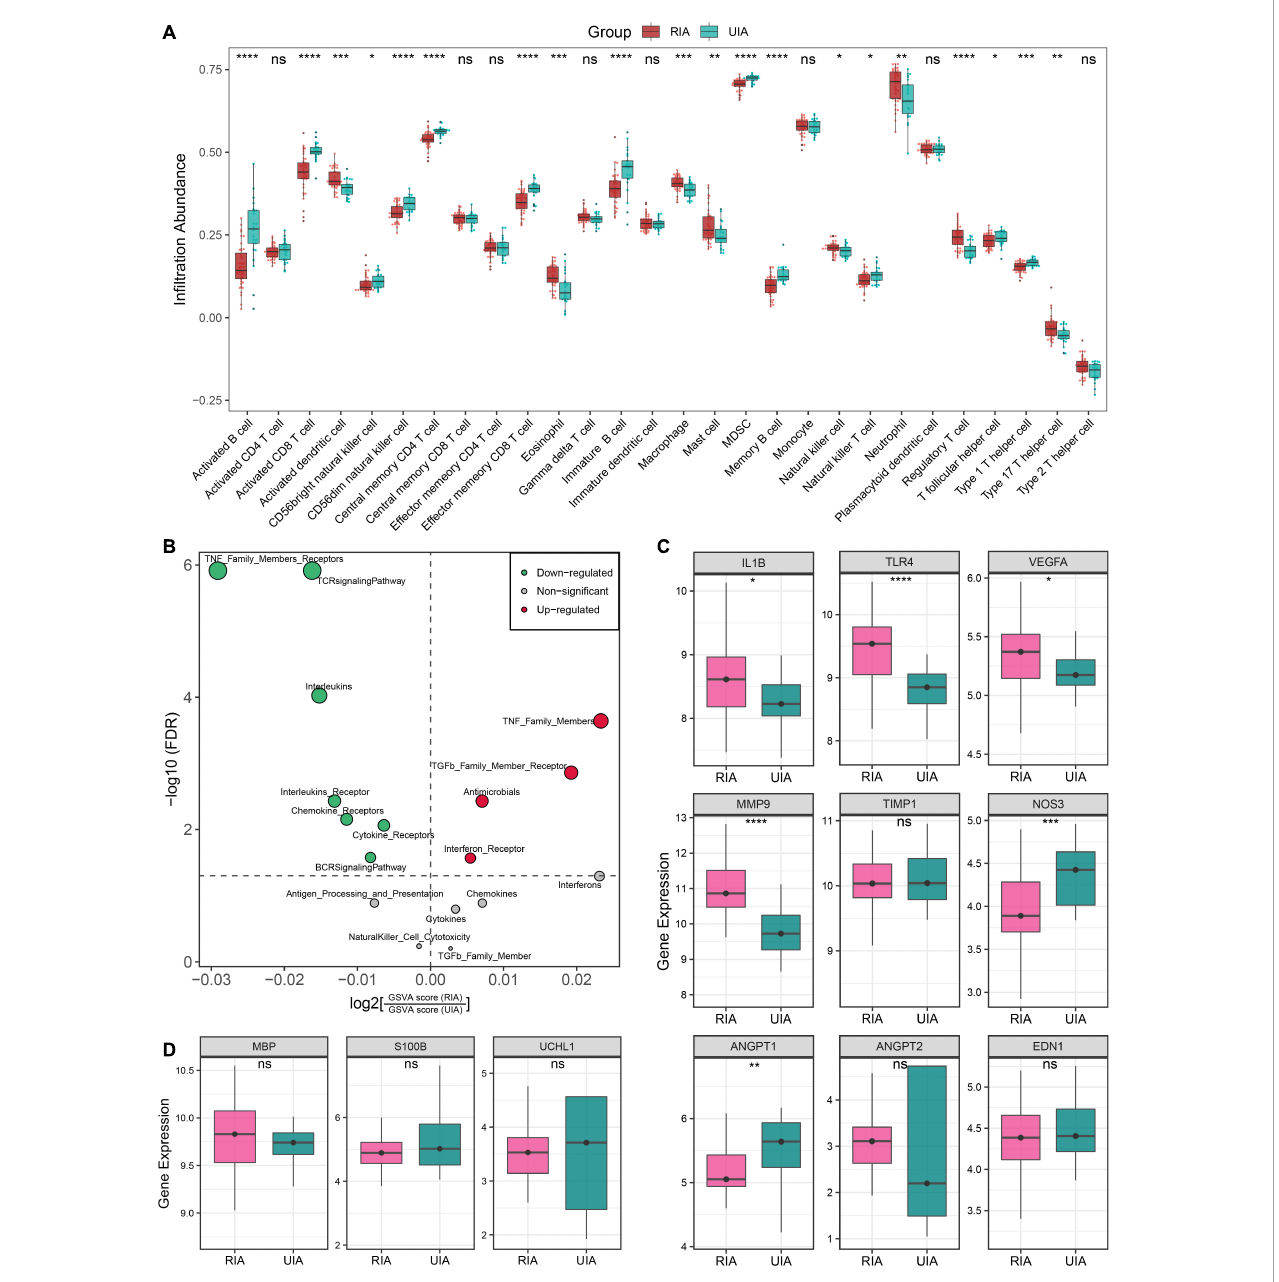
FIGURE5 Immune landscape and pathological features of peripheral circulation in patients with RIAs and UIAs. (A) Relative infiltration abundance of 28 immune cell subtypes between RIA and UIA groups. (B) Volcano plot of differentially enriched immune-related gene sets. Red and green dots indicate globally up-regulated and down-regulated gene sets, respectively. (C,D) Relative expression of genes regarding vascular stability (C) and brain injury (D) between RIA and UIA groups in our in-house cohort. Statistic tests: two-sided t -test: ns P > 0.05, * P < 0.05, ** P < 0.01, *** P < 0.001, and**** P <